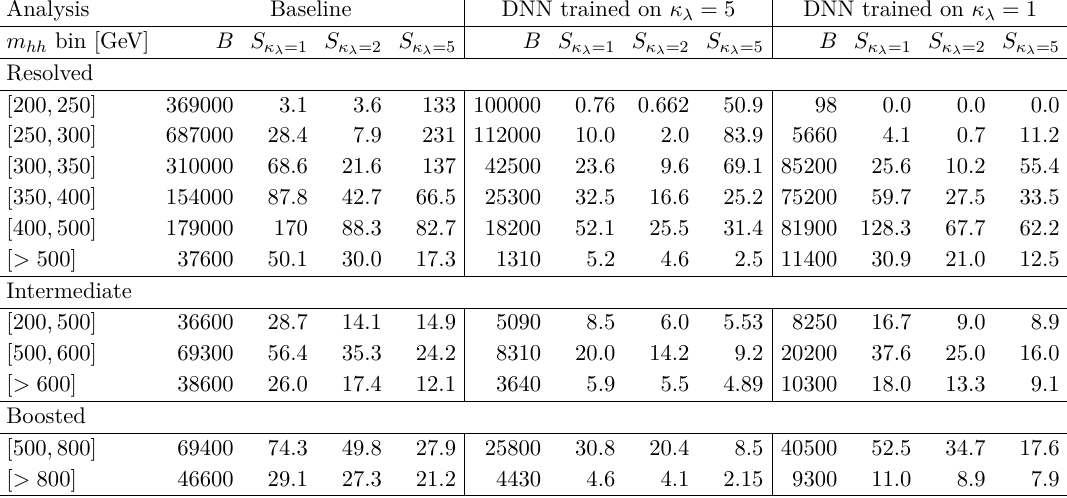
Table 5. Summary of signal region event yields binned by m hh for the total background B and benchmark signals for different κ λ couplings S κ . These are displayed for the baseline and neural λ = i network (DNN) trained on κ λ = 5 , and trained on κ λ = 1 for comparison. The yields are normalised to an integrated luminosity of L = 3000 fb − 1 for the three